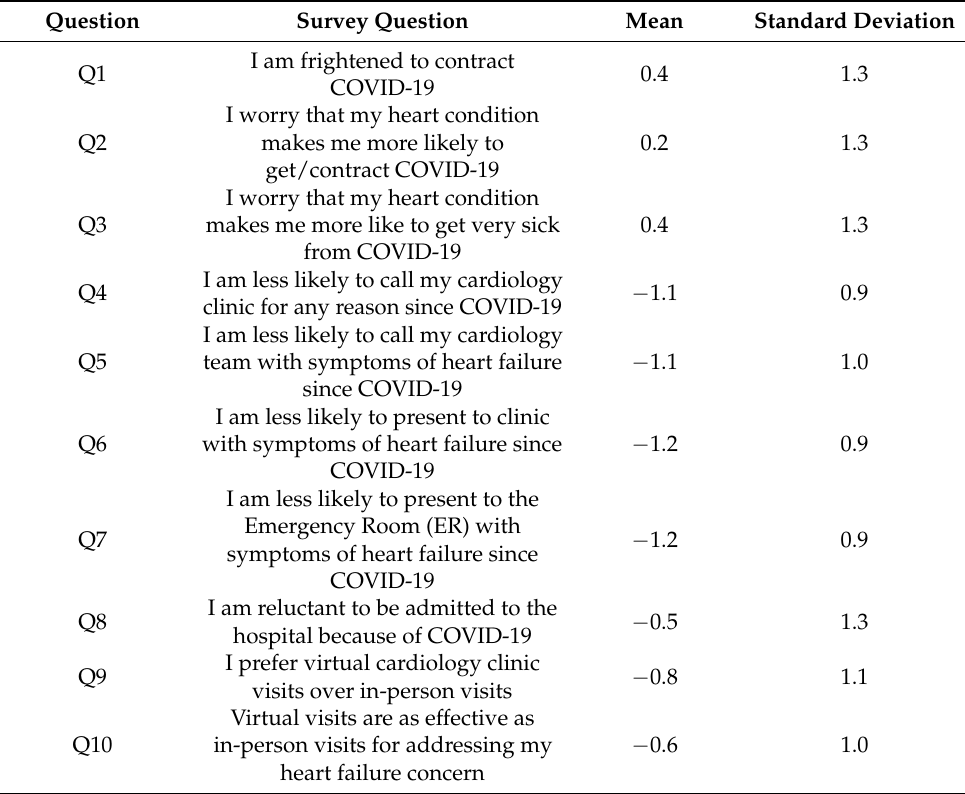
Table 2. Survey questions and distribution of responses. − 2 = strongly disagree, − 1 = disagree, 0 = neither disagree or agree, 1 = agree, 2 = strongly